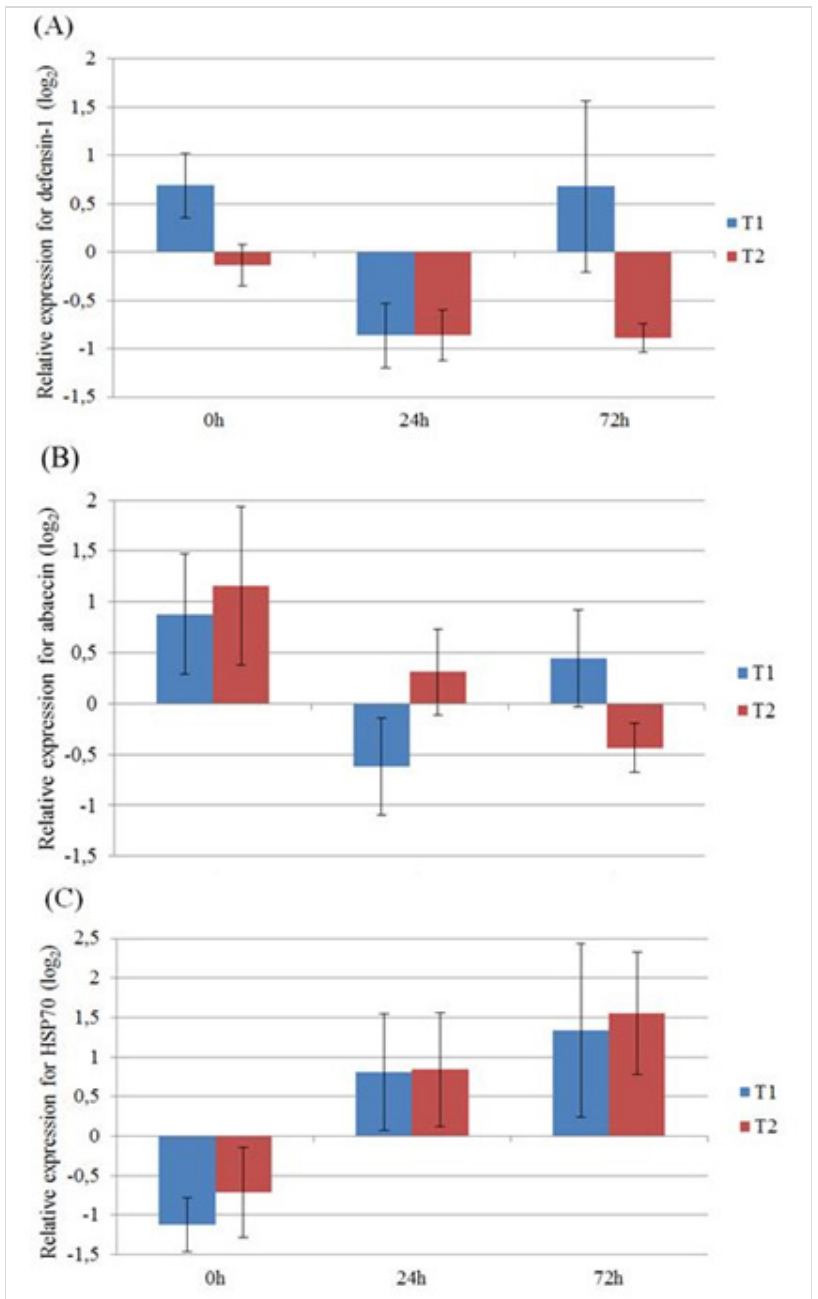
Fig 1 . Relative expression of defensin-1 (A), abaecin (B) and HSP70 (C) genes in honey bees submitted to transport for 1 hour (T50) and 2 hours (T100) and collected at 0, 24 and 72 hours after. *represents difference in relation to the control; distinct letters represent differences between the means: upper case between the treatment T50; lower case between treatment